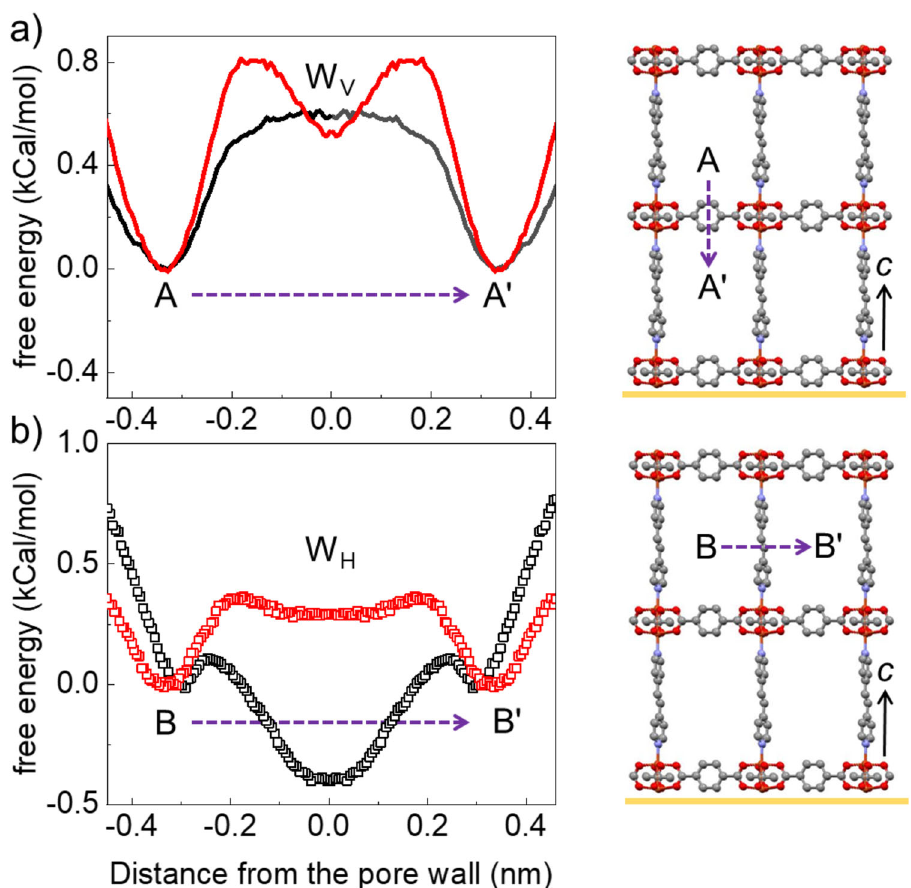
Fig. 6 | Free energy pro fi les for interpore diffusion. Free energy pro fi les of a methanol molecule during transition from one pore to the other through ( a ) W V and( b )W H ;red=PL N=N andblack=PL C=C .(Right)thenettransitionpathsareshown